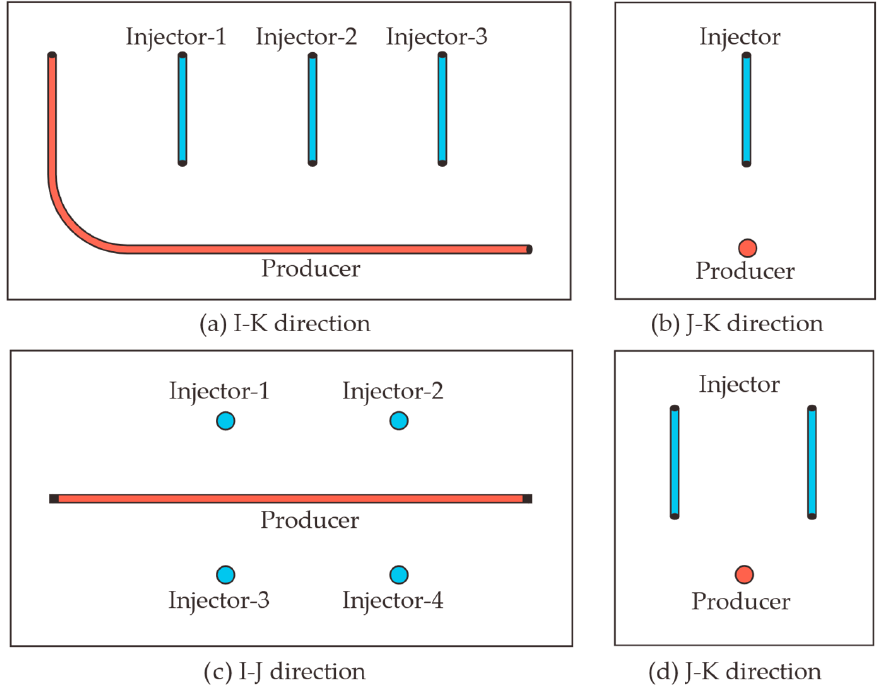
Figure 6. Two types of SAGD well layouts in the X6 reservoir: ( a , b ) linear pattern; ( c , d ) five-spot pattern. Table 1. Variables of model training.